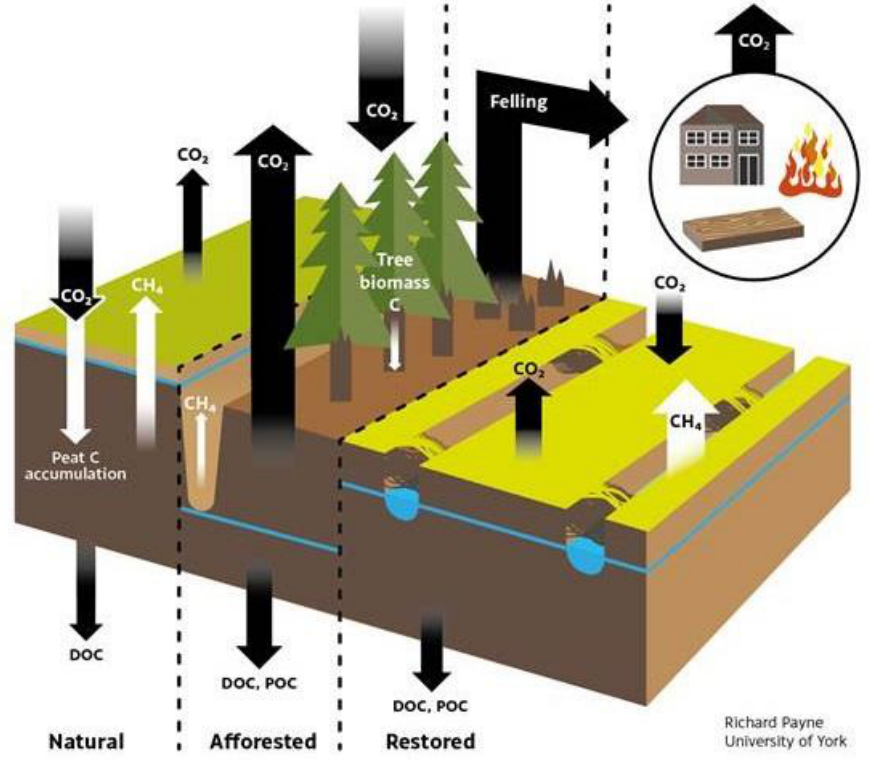
Figure 2. Conceptual diagram of key carbon cycle pathways and changes with peatland afforestation and restoration. Note that there is considerable uncertainty about the relative scale of many of these processes so the sizes of the arrows should be regarded as indicative at